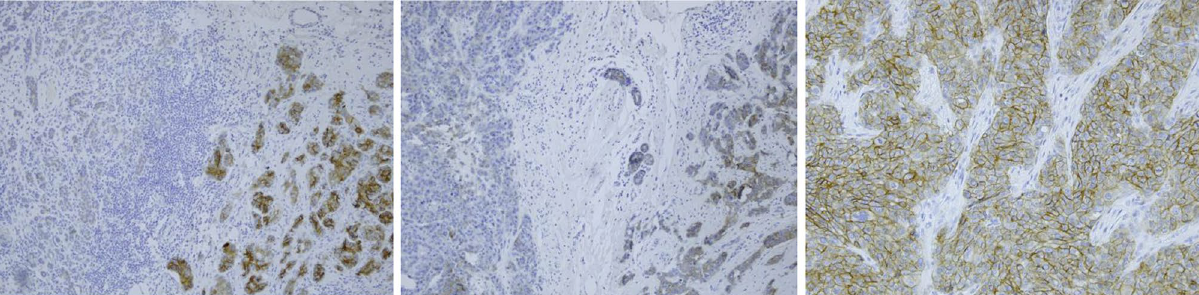
Figure 2. Expression of TROP-2 on pathological specimen. Intermediate expression of Trop-2 (left and middle), and high expression of TROP-2 (right). Positivity of TROP-2 was cytoplasmic, membranous, or both. Intermediate to low TROP-2 expression showed heterogeneous staining pattern as shown in the left and middle panel. Immunohistochemistry was scored by using the semiquantitative H-score method to better capture this heterogeneity in the lower expression